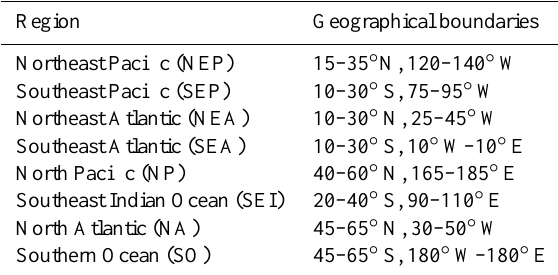
Table 1. Definitions and geographical locations of study